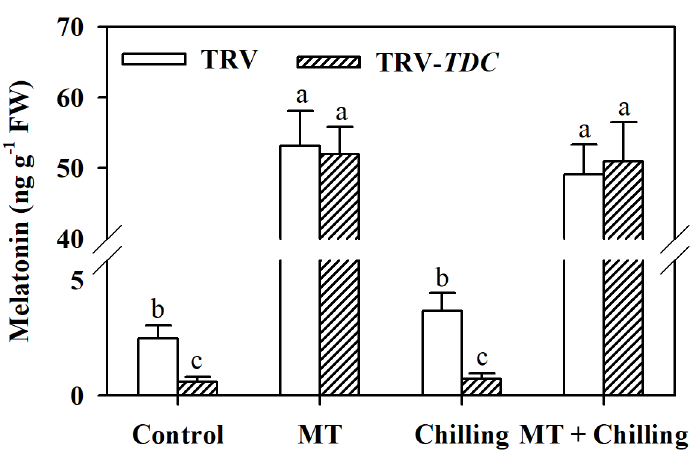
Figure 2. Silencing TDC suppresses melatonin biosynthesis, while exogenous melatonin increases melatonin accumulation in tomato leaves. Tomato plants at the 6-leaf stage were exposed to chilling stress (4 ◦ C) for 12 h and leaf samples were collected for the determination of melatonin content by HPLC. FW stands for fresh weight. TRV were those plants without TDC silencing. The values presented are means ± SDs ( n = 3). Different letters (a,b,c) above bars indicate significant difference at p < 0.05 among treatments.